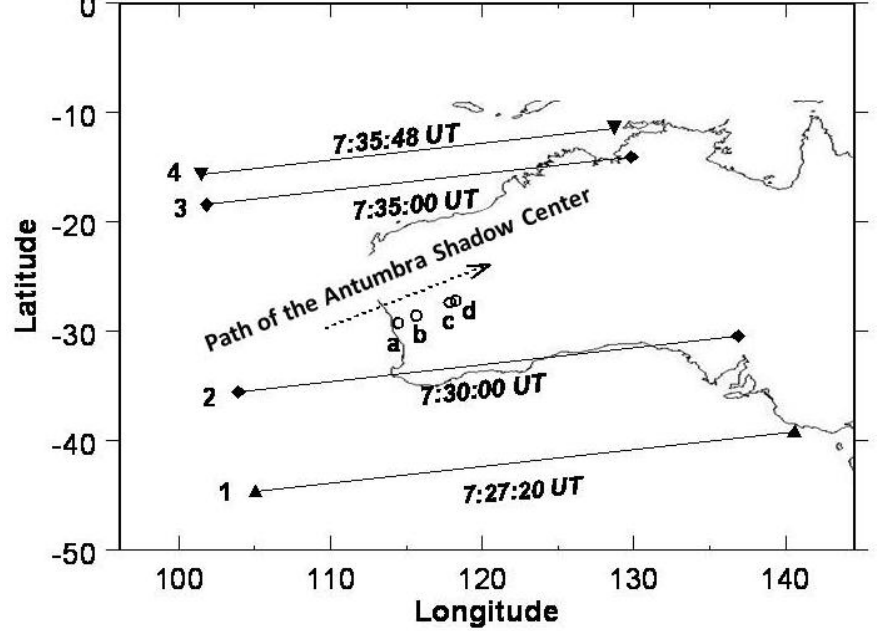
Figure 2. Instantaneous boundaries (1: south, 4: north) and approximate locations of ground resolution cells (2, 3) for the swath of ascending NOAA 14 at each time in UT; and path of the eclipse antumbra center in the same time order (a: 07:27:20, b: 07:30:00, c: 07:35:00 and d: 07:35:48) on February 16, 1999.